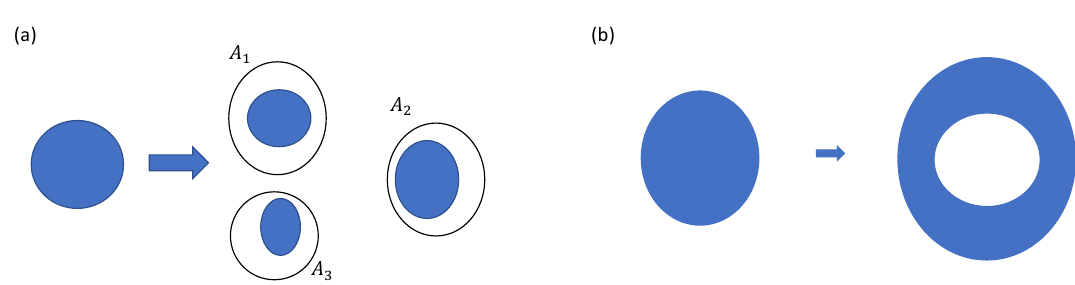
Figure 2 . In more than one spatial dimension, void formation can either break up a single op- erator into disconnected parts, as in (a), or form a hole in an operator, as in (b). In the figure, shaded regions indicate where the operator has nontrivial support. A process like (a) contributes to multipartite entanglement between the three disjoint regions A 1 , A 2 , and A 3